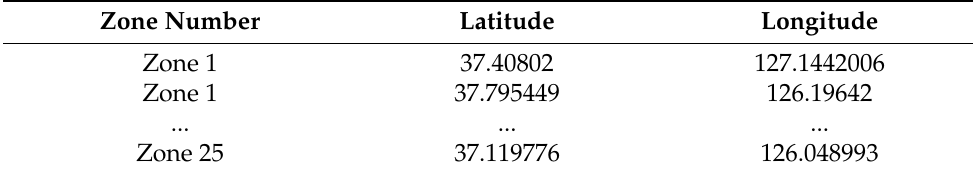
Table 4. Overview of taxi